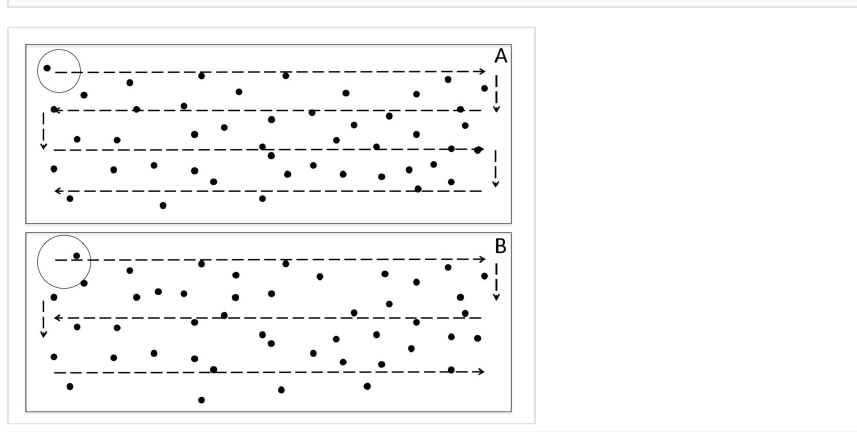
Setting of litter fall traps at the zero line (edge).